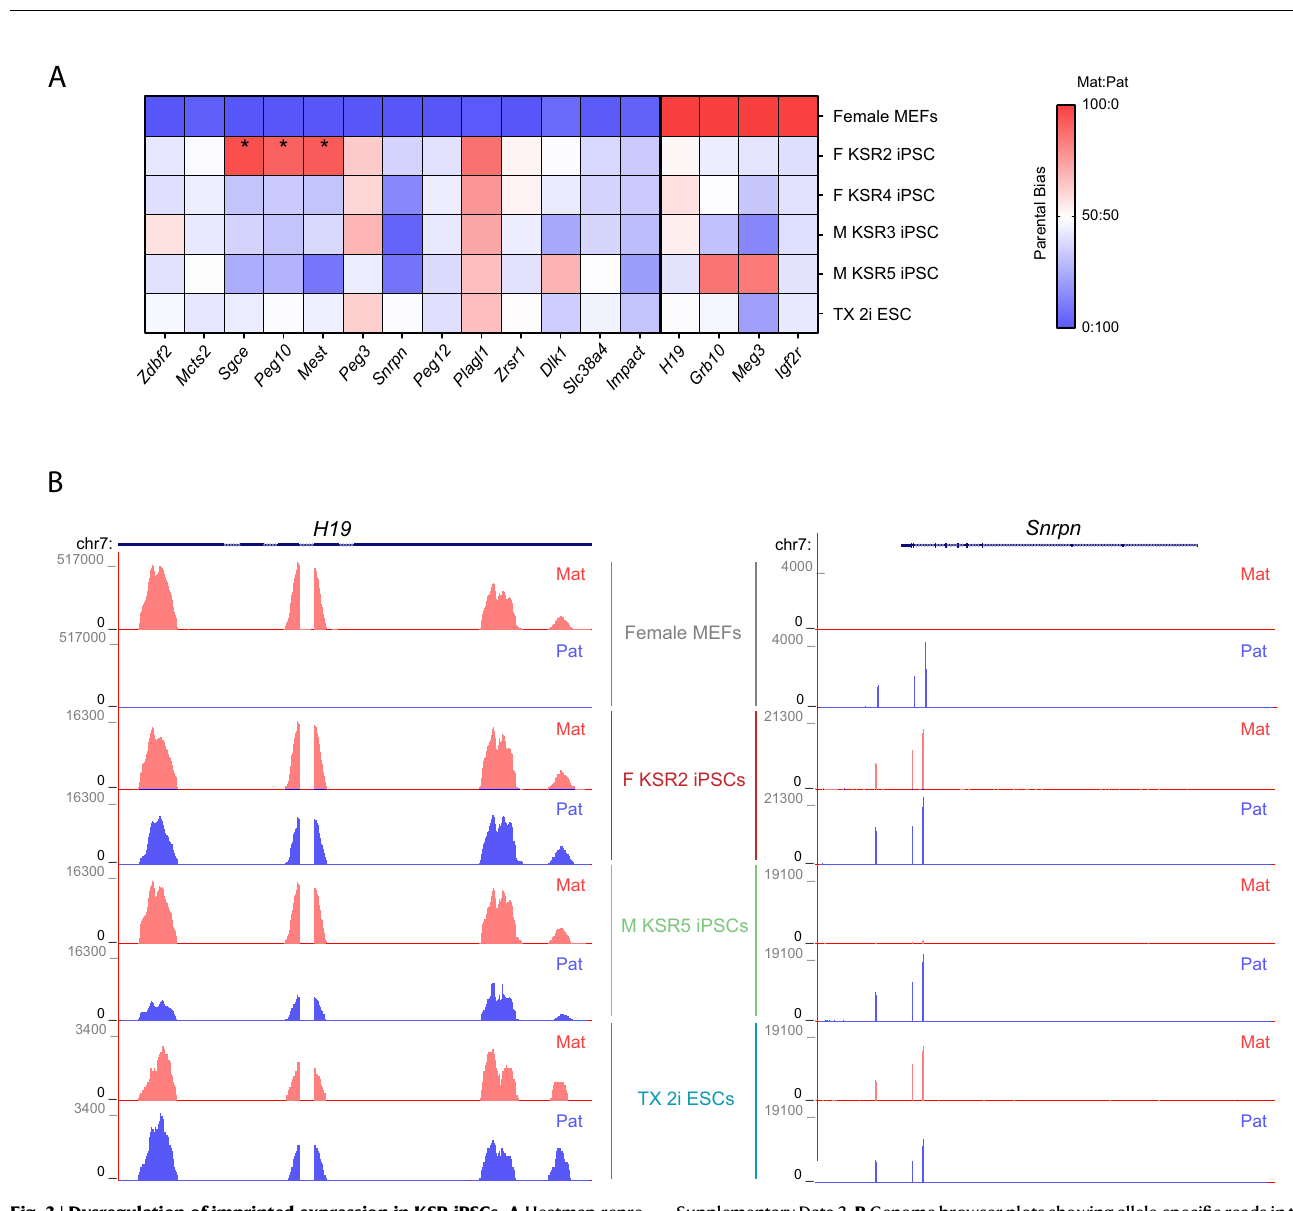
Fig. 2 | Hypomethylation defects in KSR-iPSCs. A Methylation analysis of Peg3 , Dlk1-Dio3, Igf2-H19 and PWS/AS ICRs in female and male MEFs, female (F KSR1-6) and male (M KSR1-6) iPSCs and TX 2i ESCs; Each graph represents the mean per- centage ± SD methylation levels measured at each CpG within different genomic regionsperparentalalleleforeachsample(numberofCpGperlocus- Peg3 : n =24; Dlk1-Dio3 : n =27; Igf2-H19 : n =16; PWS/AS: n =15); Scheme on the bottom of each graph represents the normal methylation status of each ICR in the correspondent regions (white circle – unmethylated ICR; black circle – methylated ICR; Mat – maternal allele; Pat – paternal allele; orange rectangles – expressed genes; grey